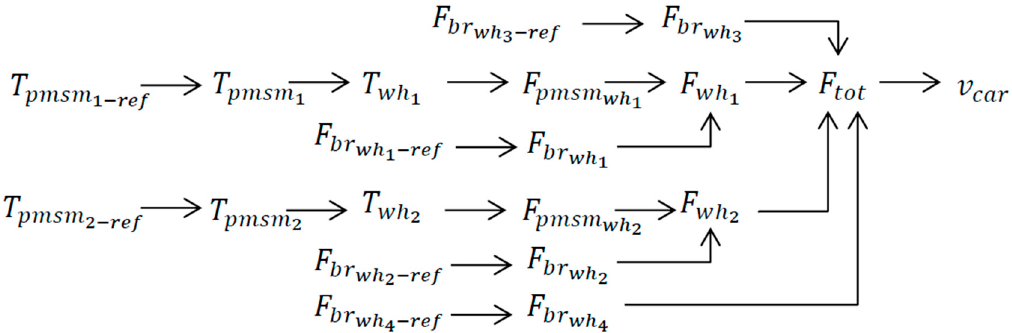
Figure 4. Tuning path of the studied car.